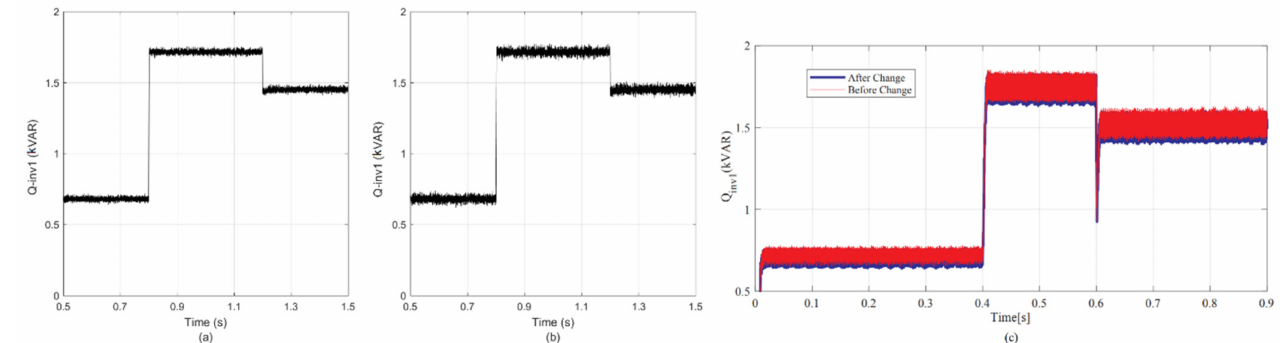
Figure 15. Reactive power of inter-linking inverter (inv1) under two different sets of MG parameters, ( a ) under first set, ( b ) under the second set, ( c ) under two different sets of MG parameters in reference [19].